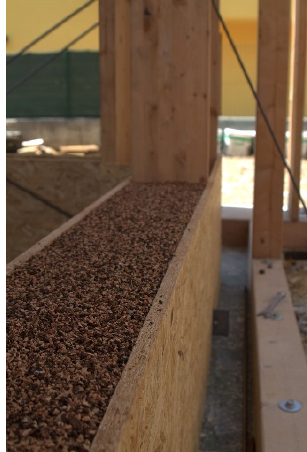
Figure 11. Cork used to drain water and for insulation purposes.